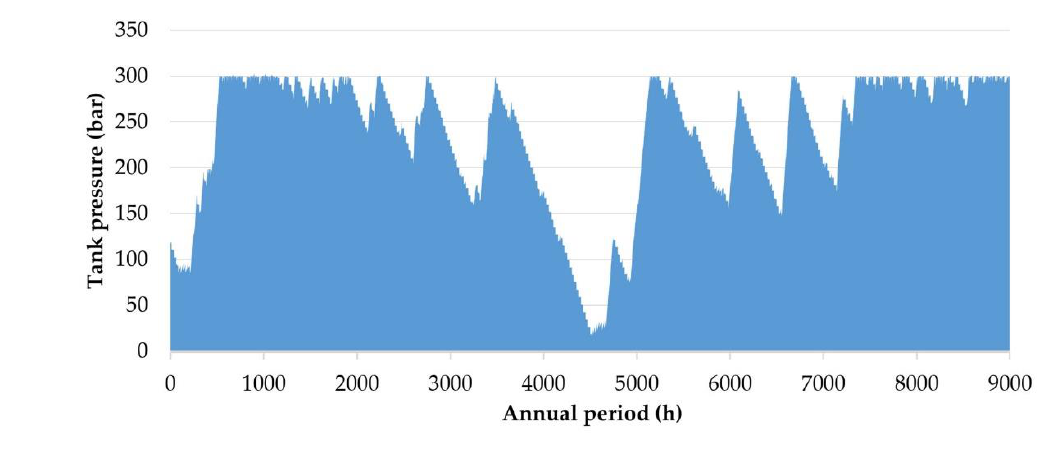
Figure 17. Annual pressure fluctuation in the hydrogen storage tank.